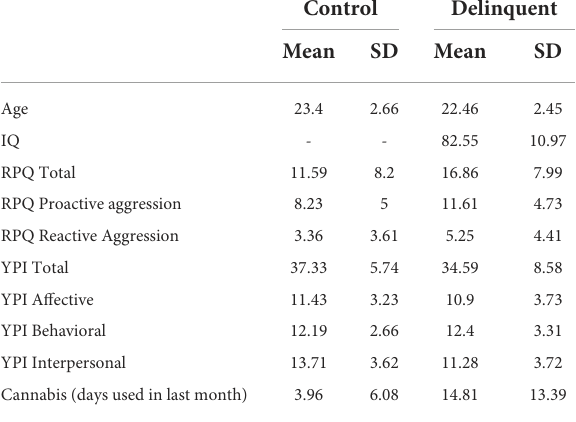
TABLE 1 Participant